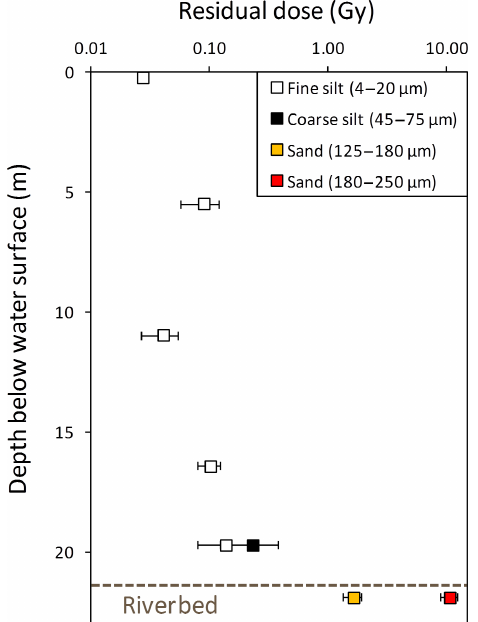
Figure 3. Residual doses of quartz silt and sand from sediments in transit in the modern Mississippi River, with sample depth in the river